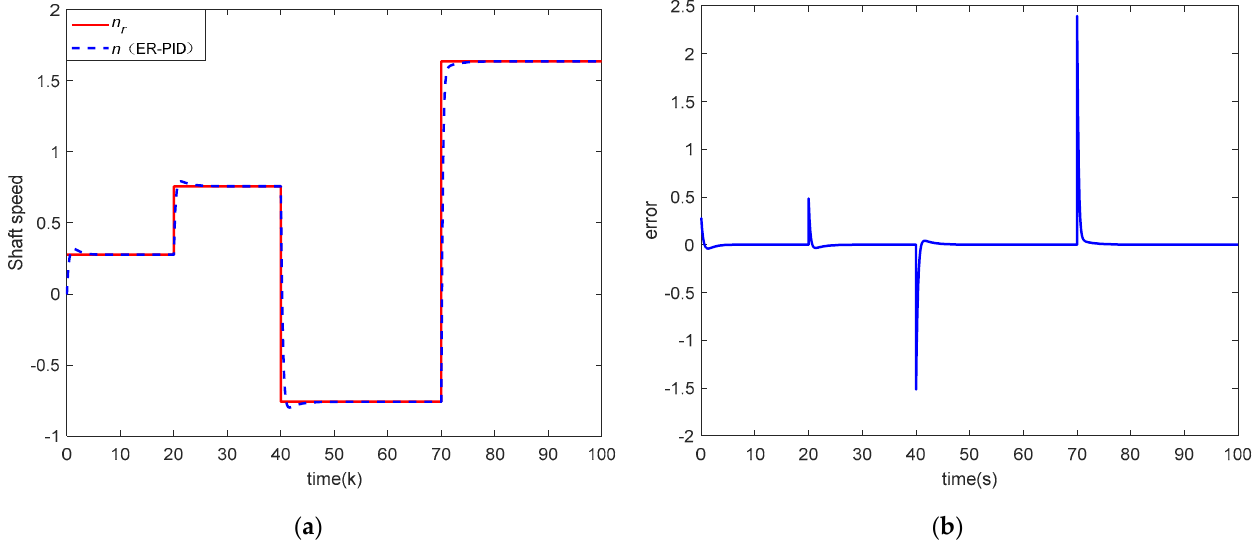
Figure 7. Tracking results of the ER ‐ PID controller. ( a ) Tracking results that n ( k ) tracks n r ( k ). ( b ) Tracking errors that n ( k ) tracks n r ( k ).